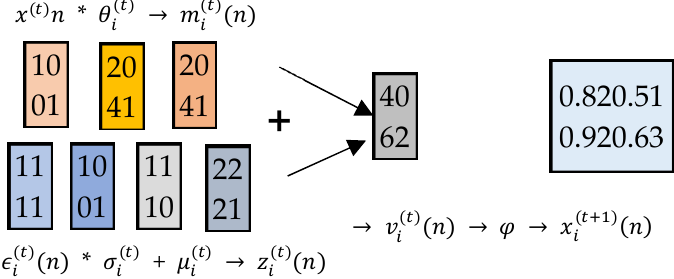
Figure 2. Optimization algorithm visualization.